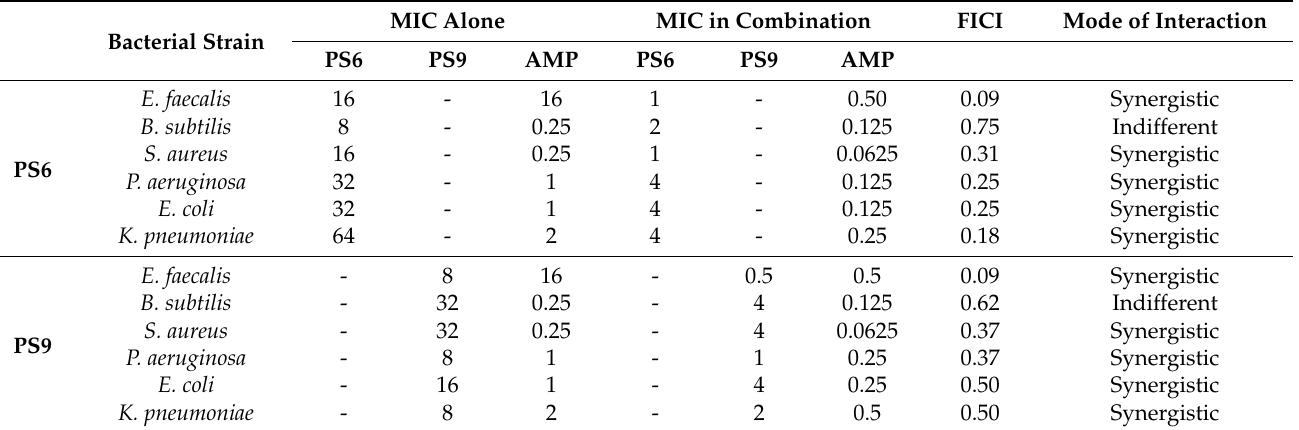
Table 5. Combination study of PS6 and PS9 with AMP ( µ